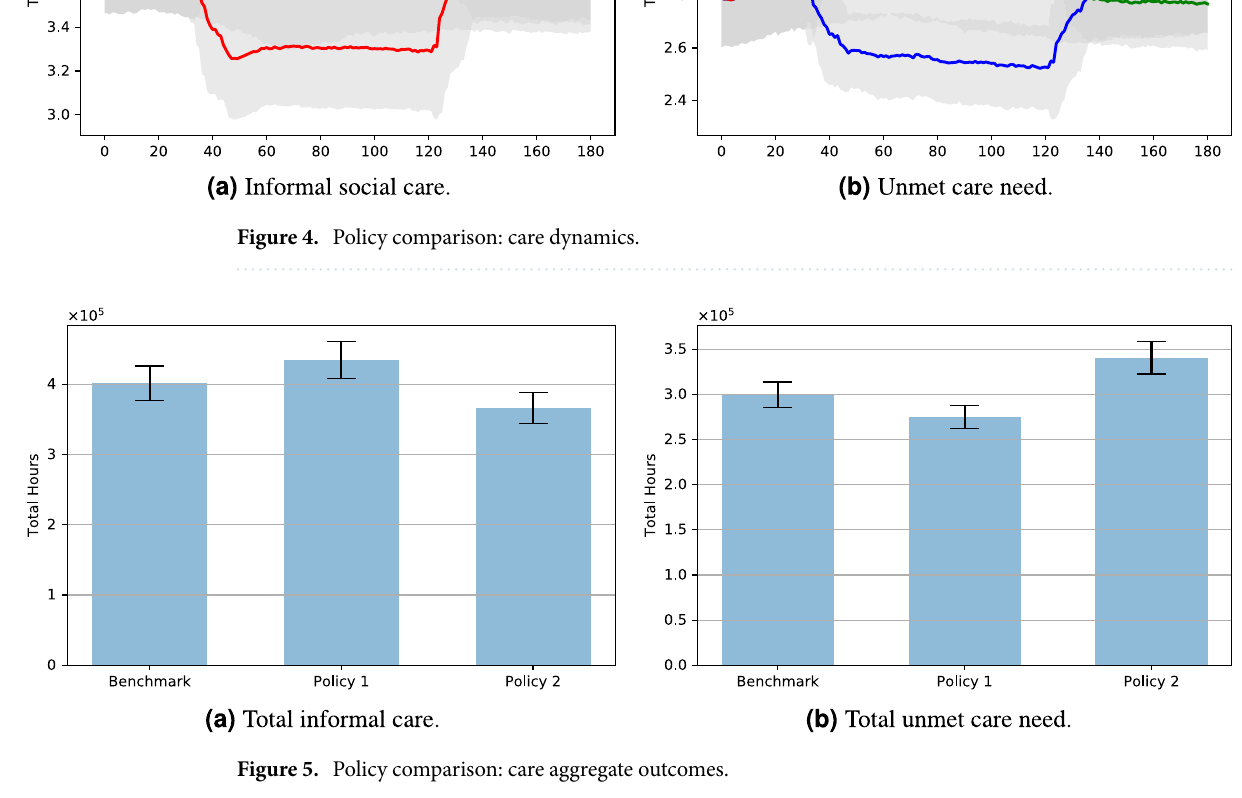
Figure 5. Policy comparison: care aggregate